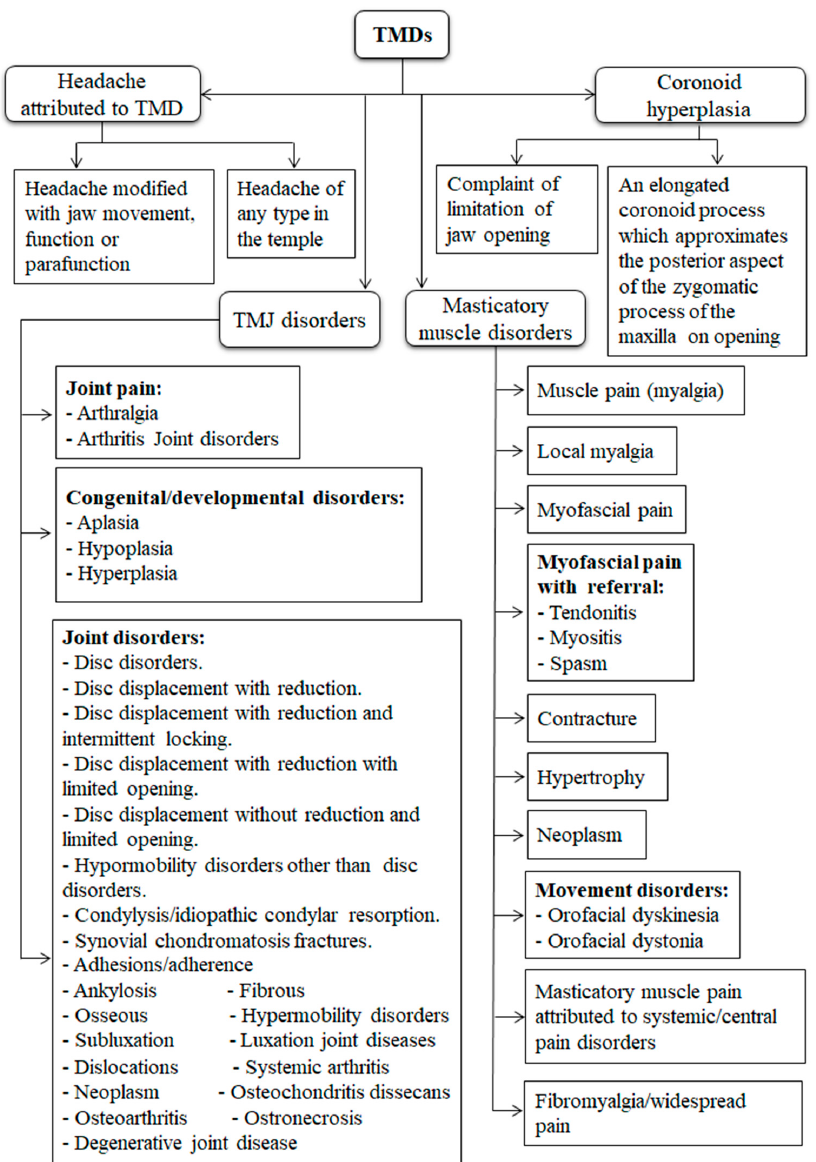
Figure 1. The taxonomic classification of temporomandibular disorders (TMDs). There are 4 main types of TMDs including temporomandibular joint (TMJ) disorders, masticatory muscle disorders, headache attributed to TMD, and coronoid hyperplasia